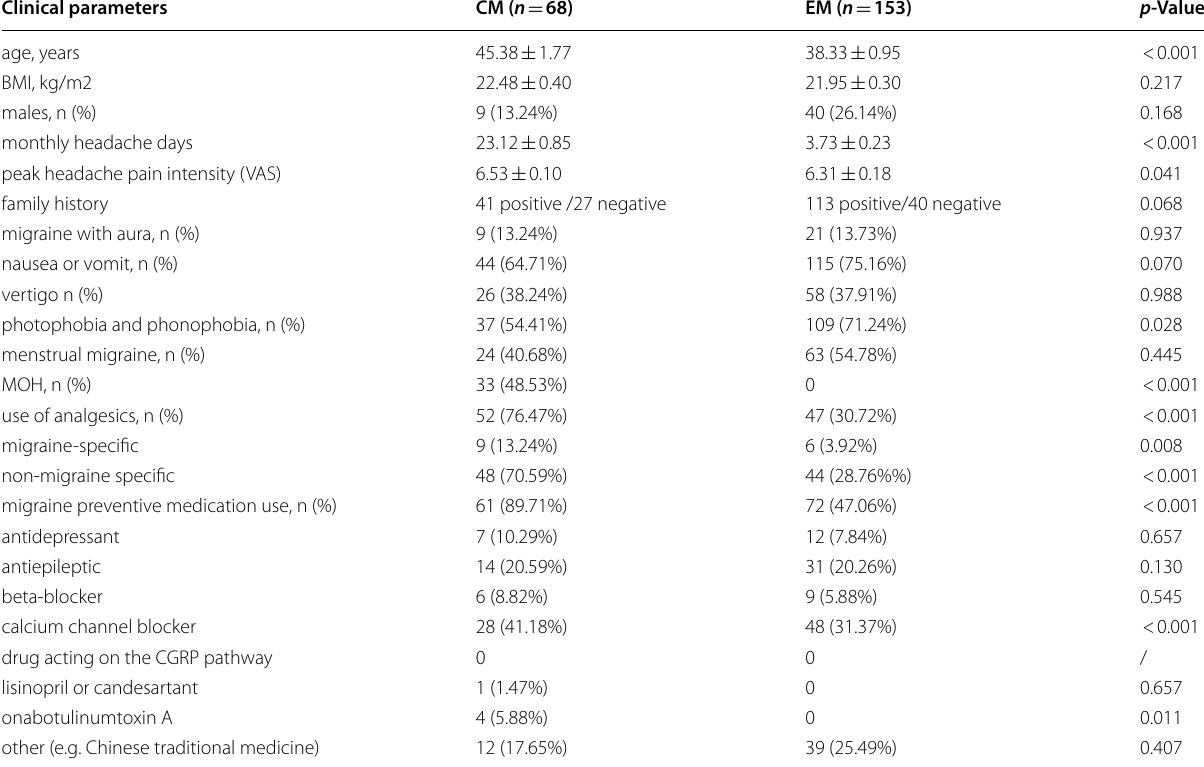
Table 2 Characteristics of CM and EM patients. Average headache days were calculated in the previous three months. Headache intensity was evaluated using VAS. For female patients, the relationship between headache attack and menstruation was counted. Values are presented as mean SE. Kruskal–Wallis test was used to analysis the difference of clinical parameters between CM and EM. ± The mean values were considered different if p < 0.05